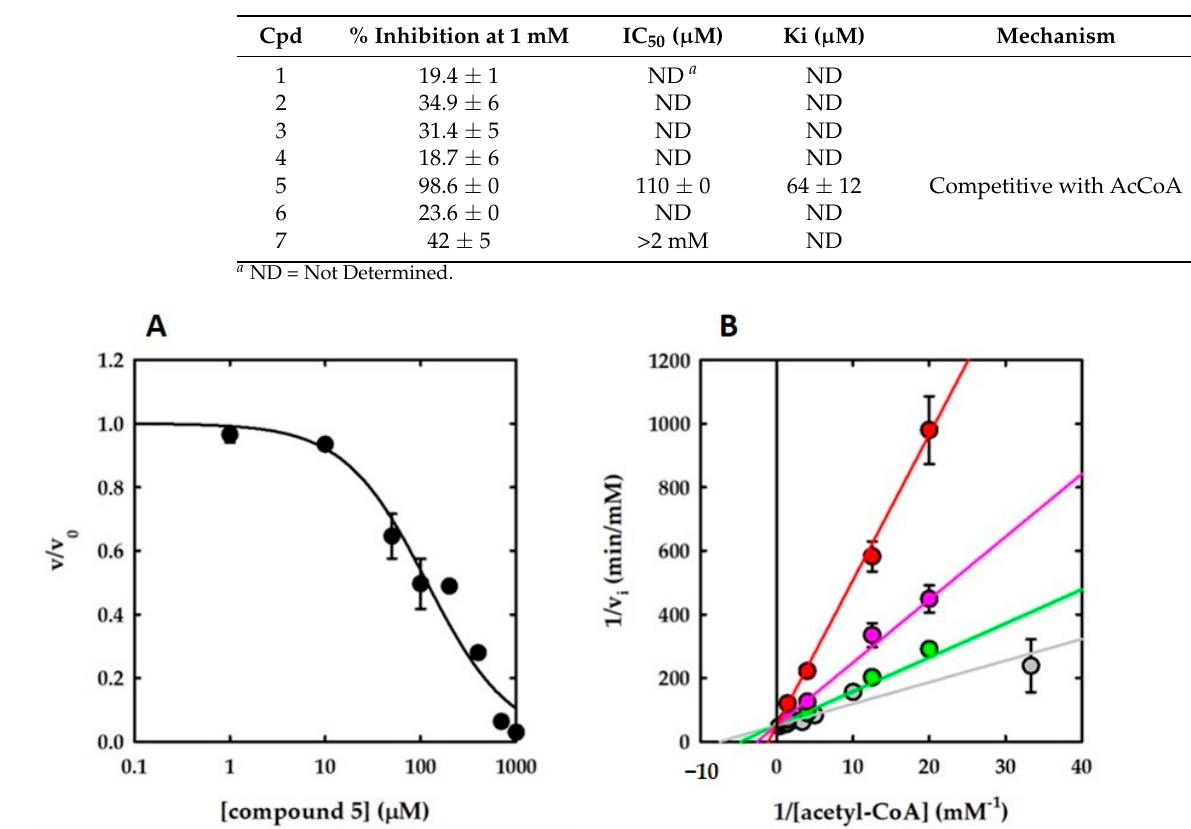
Figure 3. Inhibitory activity of compound 5 . Panel A: dependence of relative initial reaction rate on the concentration of compound 5 . The line through data points is the fitting to equation 1 with IC 50 = 110 ± 0 µ M. Panel B: dependence of the initial reaction rate on the concentration of acetylCoA in the absence of added inhibitors (grey dots) and in the presence of different concentrations of compound 5 (green dots 30 µ M; pink dots 100 µ M, red dots 300 µ M). The series of lines through data points is the fitting to the linearised form of equation 2 with K i = 64 ± 12 µ M.